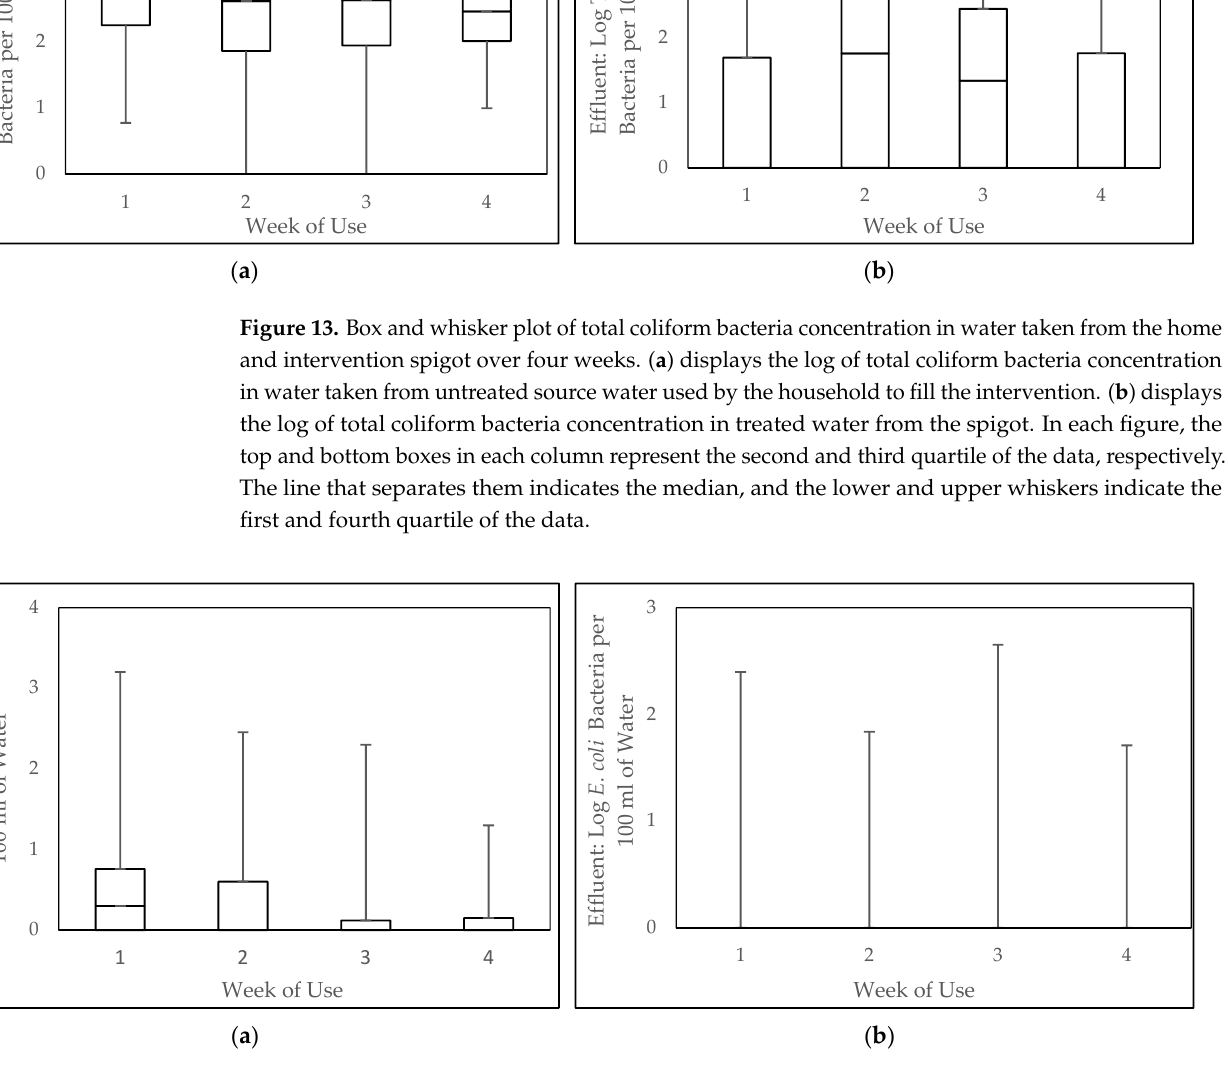
Figure 14. Box and whisker plot of E. coli bacteria concentration in water taken from the home and intervention spigot over four weeks. ( a ) displays the log of E. coli bacteria concentration in water taken from untreated source water used by the household to fill the intervention. ( b ) displays the log of E. coli bacteria concentration in treated water from the spigot. In each figure, the top and bottom boxes in each column represent the second and third quartile of the data, respectively. The line that separates them indicates the median, and the lower and upper whiskers indicate the first and fourth quartile of the data.